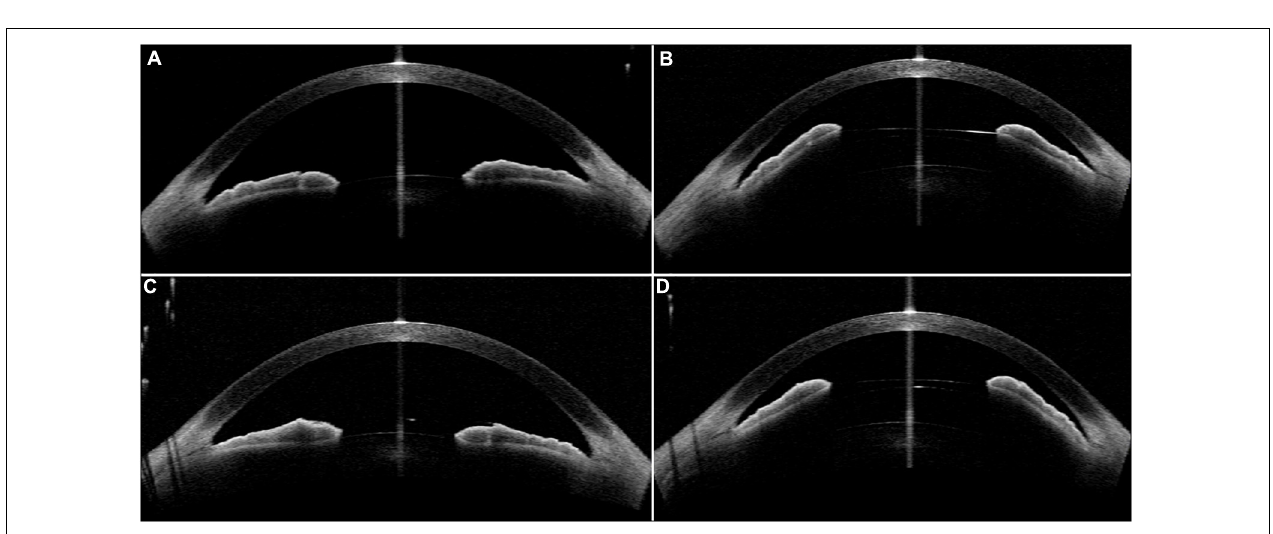
FIGURE 5 | Case 2: (A,C) Convex shape iris before surgery; (B,D) high vault was shown in both eyes 1 month after ICL implantation. (Row 1: right eye; Row 2: left